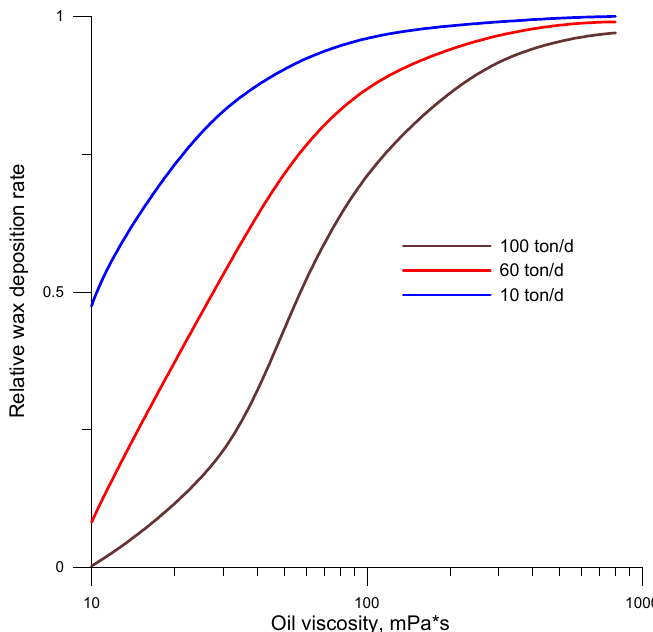
Figure 4. Influence of oil viscosity on the relative wax deposition rate for different waterless well flow rates, C asph = 0.05, C o = 0.0546 .